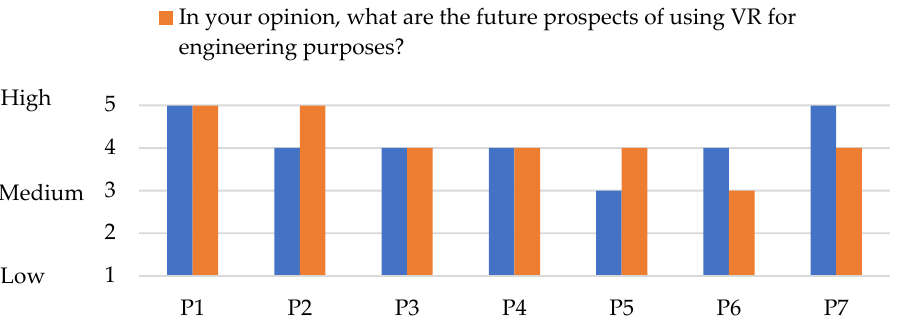
Figure 5. Participants beforehand opinion and interest in VR technology.